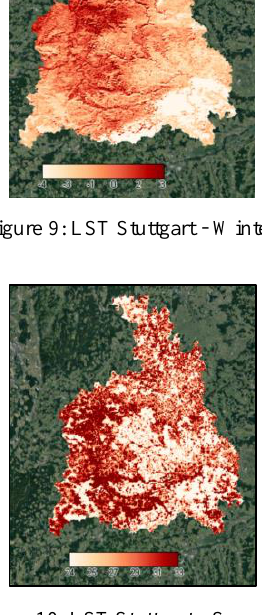
Figure 10: LST Stuttgart - Summer.